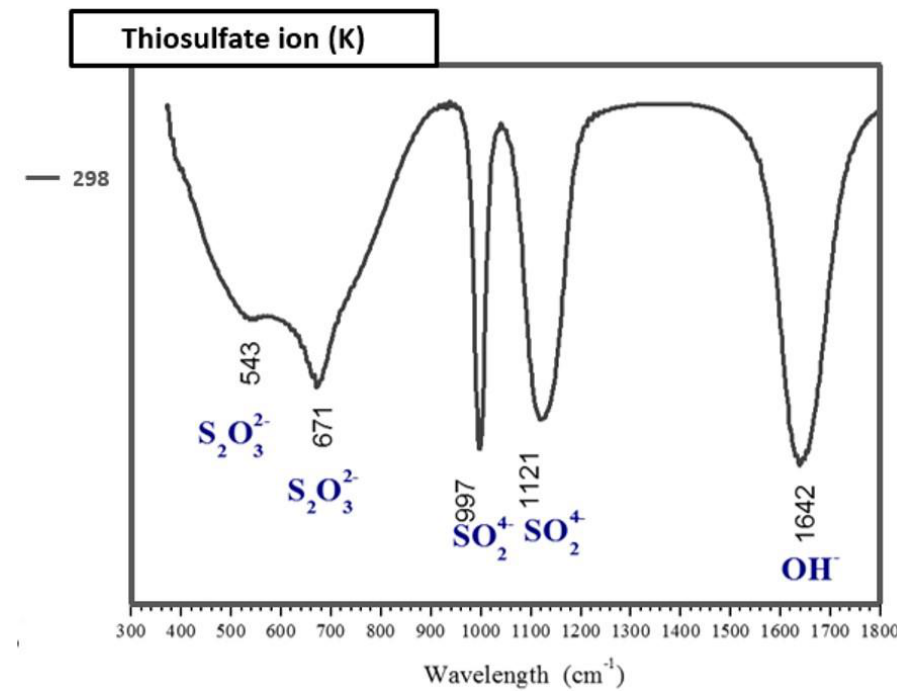
Figure 9. Infrared spectrum corresponding to thiosulfate ion at 298 K.